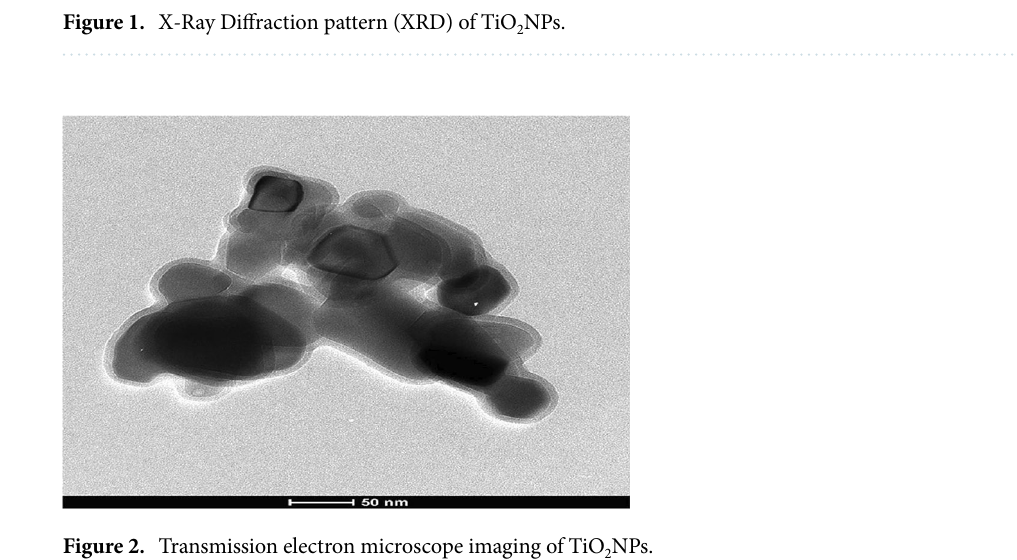
Figure 2. Transmission electron microscope imaging of TiO 2 NPs.